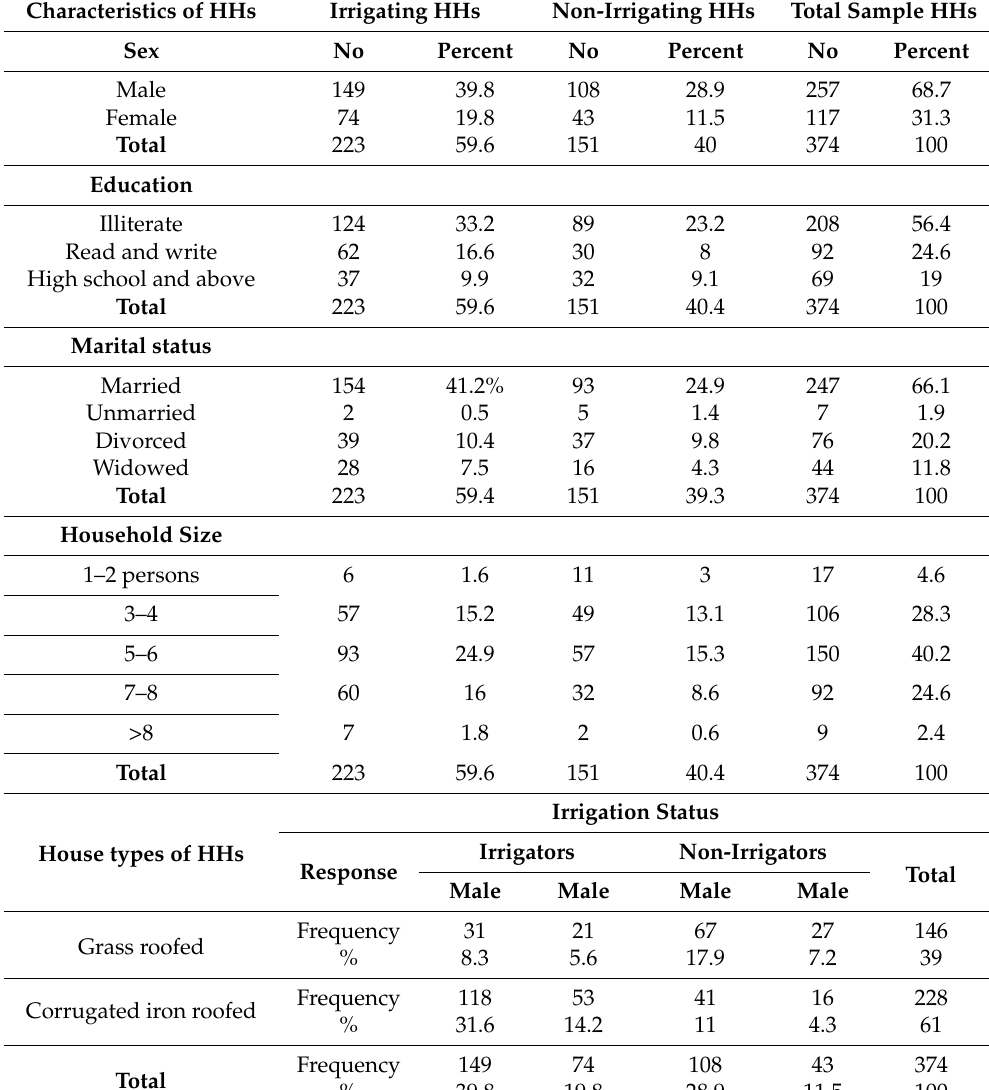
Table 2. Respondents’ sex, education, house types, household size and marital